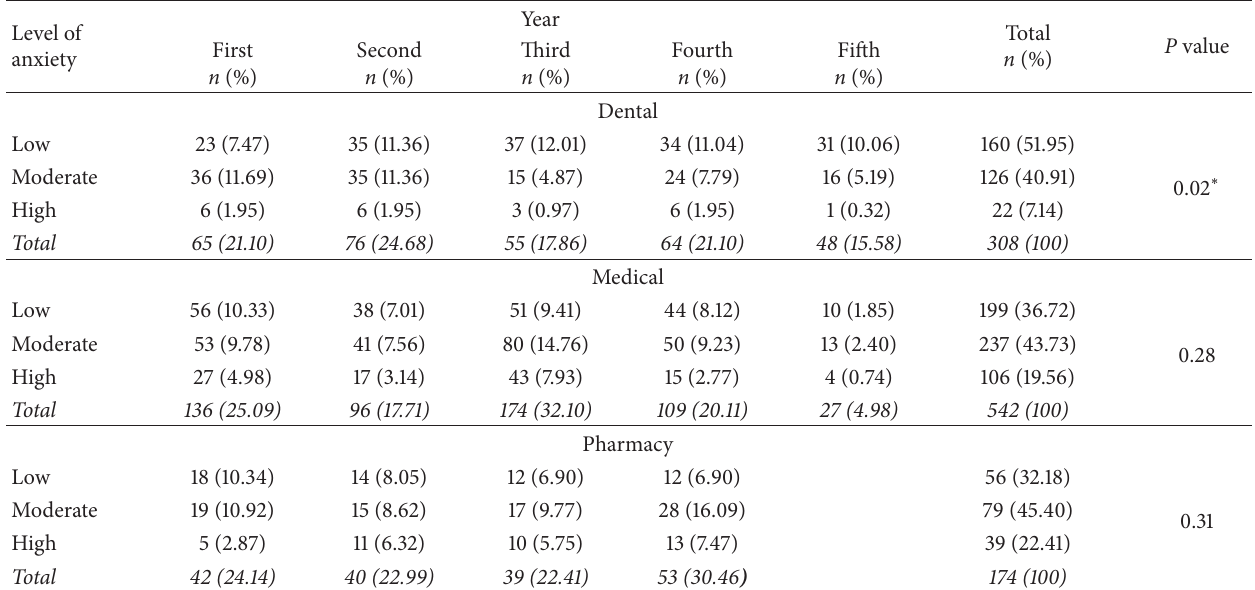
Table 3: Year-wise distribution of study subjects by the level of dental anxiety and field of study. Level of